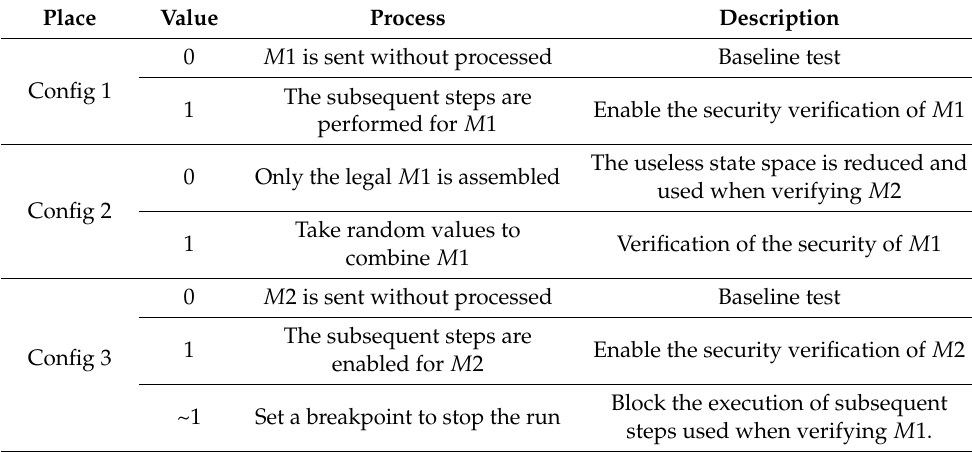
Table 3. Description the values of places Config